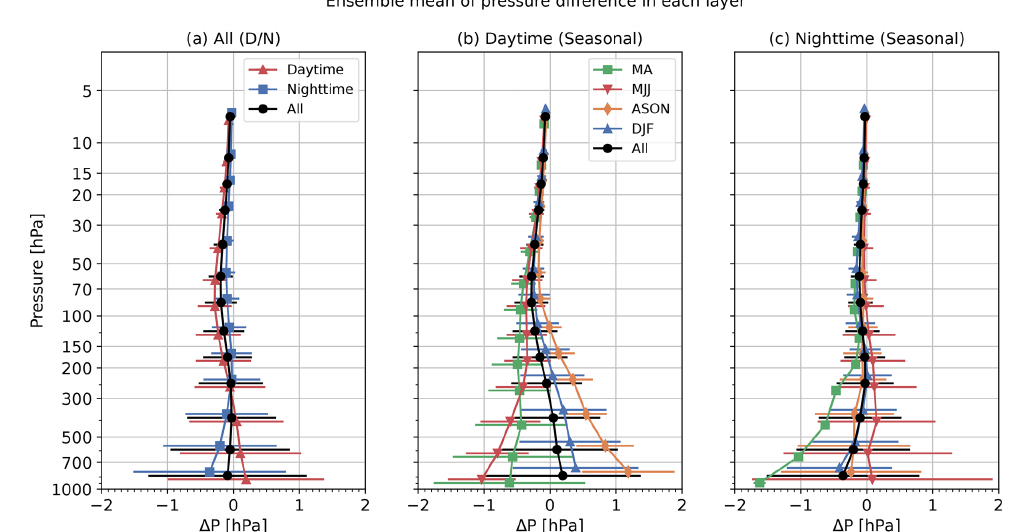
Figure 25. As per Fig. 18 but for pressure.